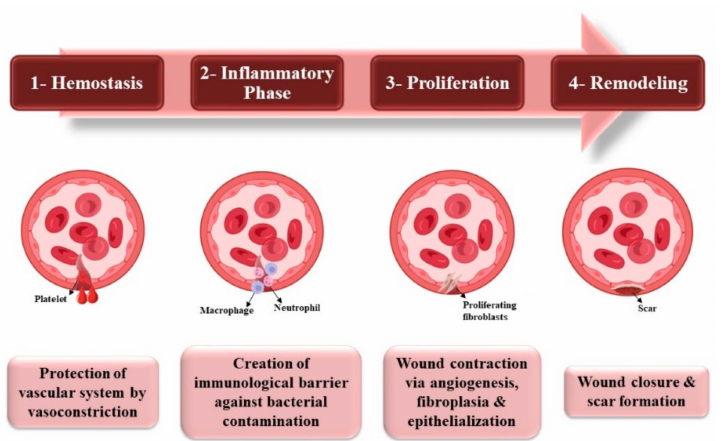
Figure 2. A schematic representation illustrating the different stages of wound healing. (Created with BioRender.com; accessed on 12 December